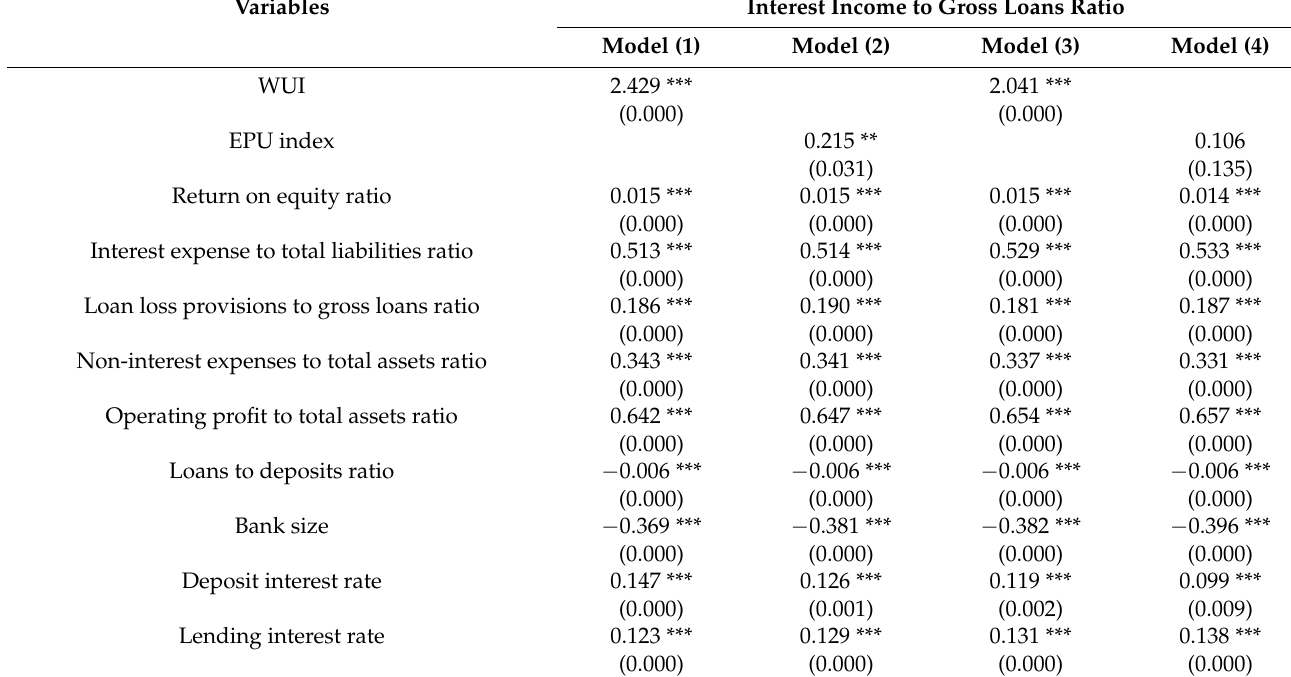
Table 8. Economic and political uncertainty and bank loan pricing: Comparison of WUI and EPU indexes. This table reports results regarding the comparison of WUI and EPU indexes. Bank loan interest rate is measured with annual ‘interest income to gross loans ratio’ and is dependent variable in all models. WUI is world uncertainty index of Ahir et al. (2018) which represents economic uncertainty. EPU index is the economic policy uncertainty index of Baker et al. (2016). Others are control variables. Detailed definitions of variables are given in Table 2. The results are estimated with pooled OLS estimator using heteroskedasticity robust standard errors. P -values are given in parenthesis. ***, **, * represent statistical significance at 1%, 5%, and 10% levels,